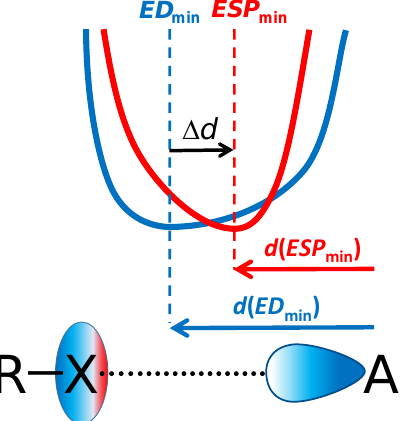
Figure 1. Schematic representation of a halogen bond (X—halogen atom, A—nucleophilic site), ED (blue) and ESP (red) distributions along the bond path. The graphical definition of d ( ED min ) (blue), d ( ESP min ) (red), and Δ d (black) are given.